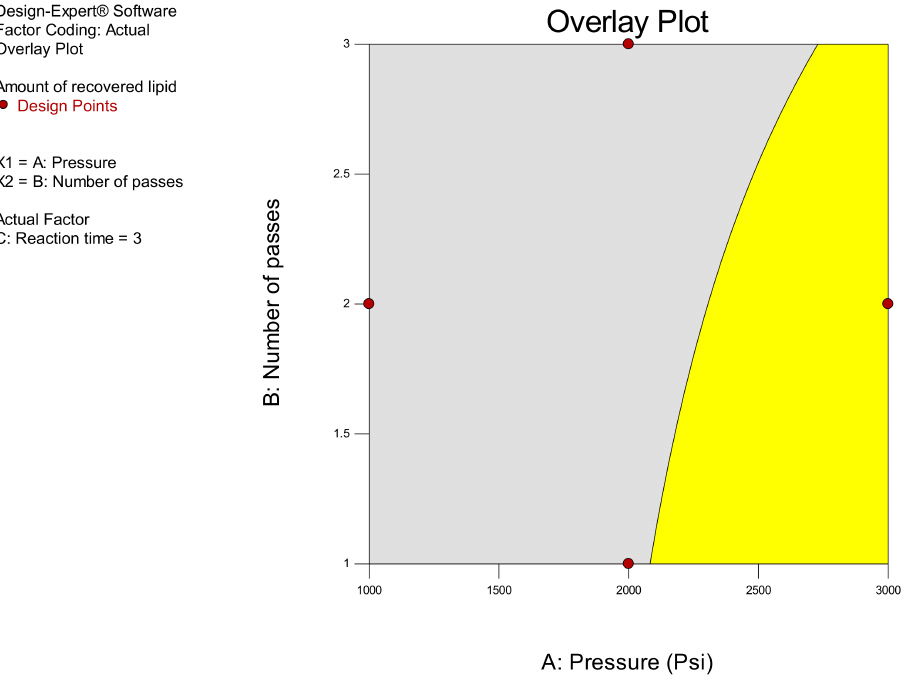
Figure 5. Graphical optimization for maximizing the percentage of recovered lipid yield minimizing pressure.